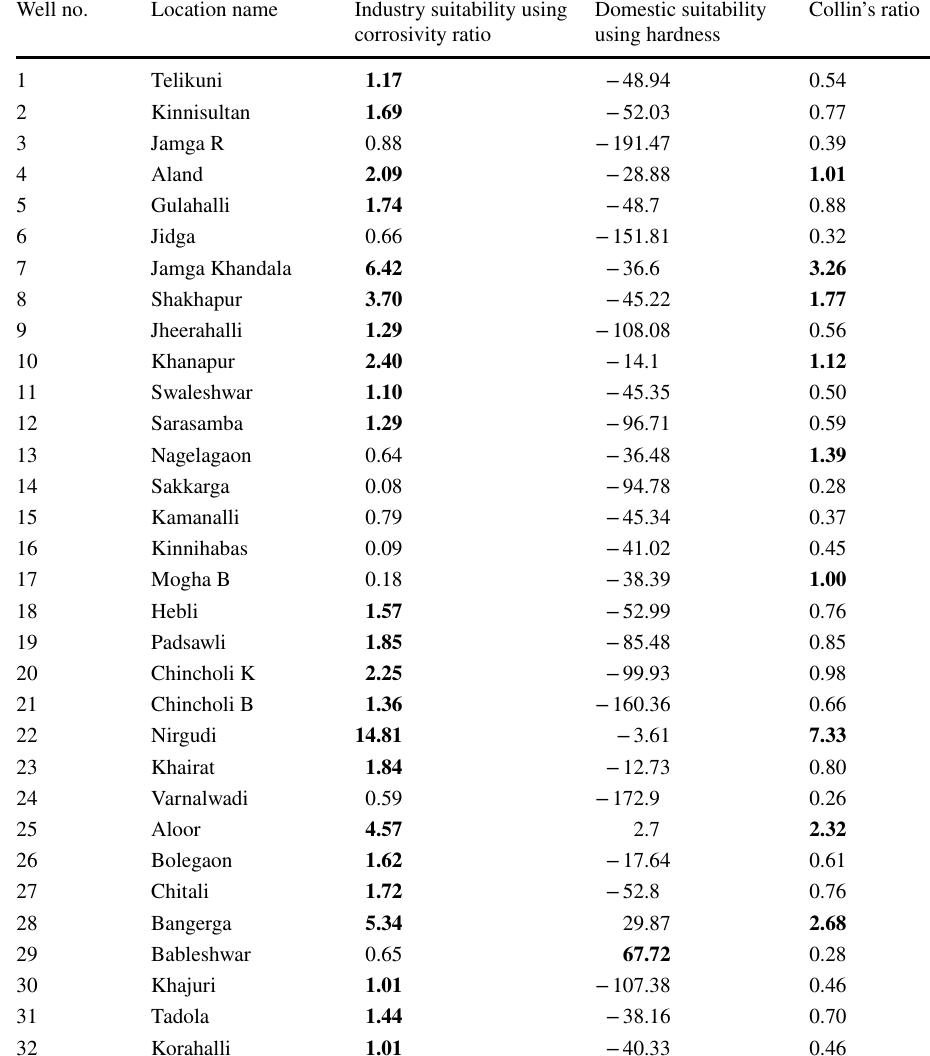
suitability of groundwater (post- monsoon season)